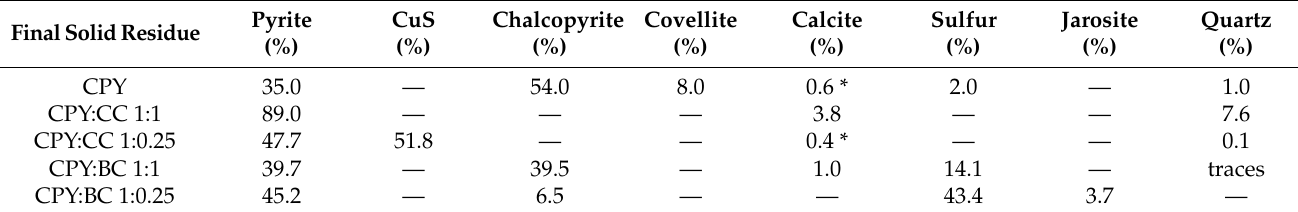
Table 4. XRD analysis of final solid residues after leaching process.